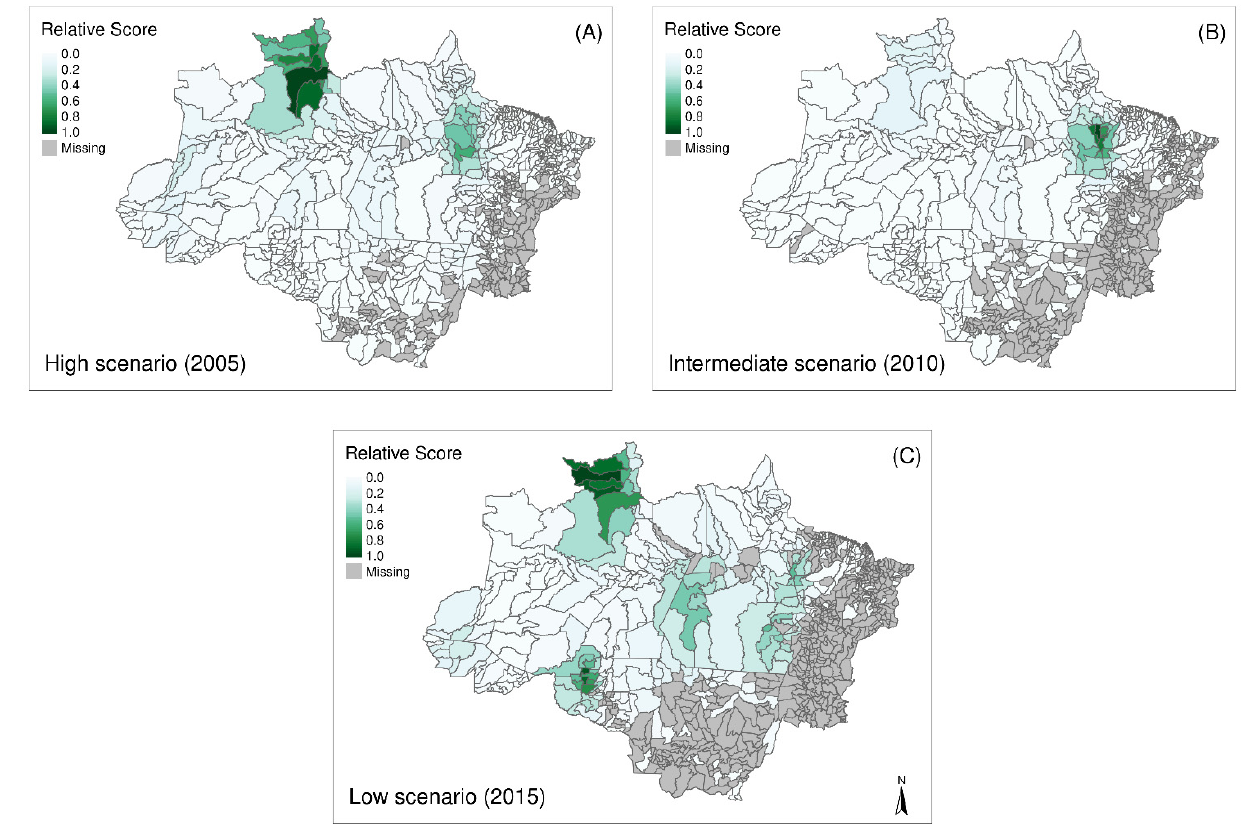
Figure 6. Spatial distribution and detection of clusters of recurrences up to 28 days in municipalities in the Amazon in ( A ) 2005–High transmission scenario, ( B ) 2010–Intermediate transmission scenario, and ( C ) 2015–Low transmission scenario.